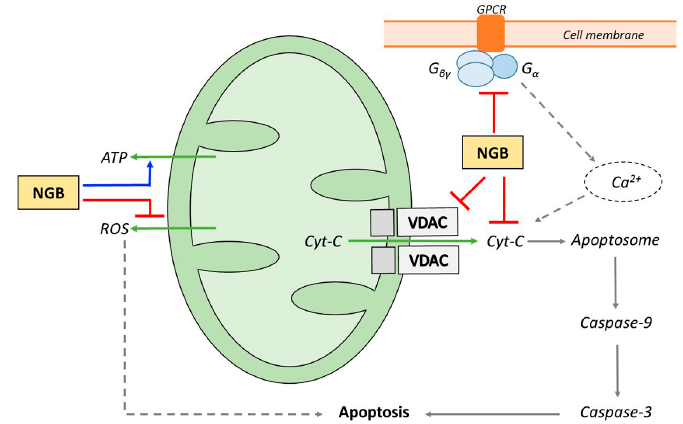
Figure 2. Simplified scheme illustrating the potential mechanisms of neuroglobin (NGB) neuroprotection modulating mitochondria. On the left, actions based on the interaction with heme-iron ligands are indicated. They involve preserving mitochondrial ATP production and scavenging of ROS (see [12]). On the right, processes based on the interaction with proteins involved in the regulation of the intrinsic pathway of apoptosis are reported. They include direct interactions with G proteins [61], voltage-dependent anion channel (VDAC) [62] and especially with cytochrome c (Cyt-C) [63]. The whole pattern of reactivity can contribute to the inhibition of the apoptotic process (see text). Blue arrows emphasize stimulatory and red lines inhibitory NGB actions. Solid arrows illustrate the steps of the intrinsic pathway of apoptosis. Other relevant processes are indicated by dashed arrows.